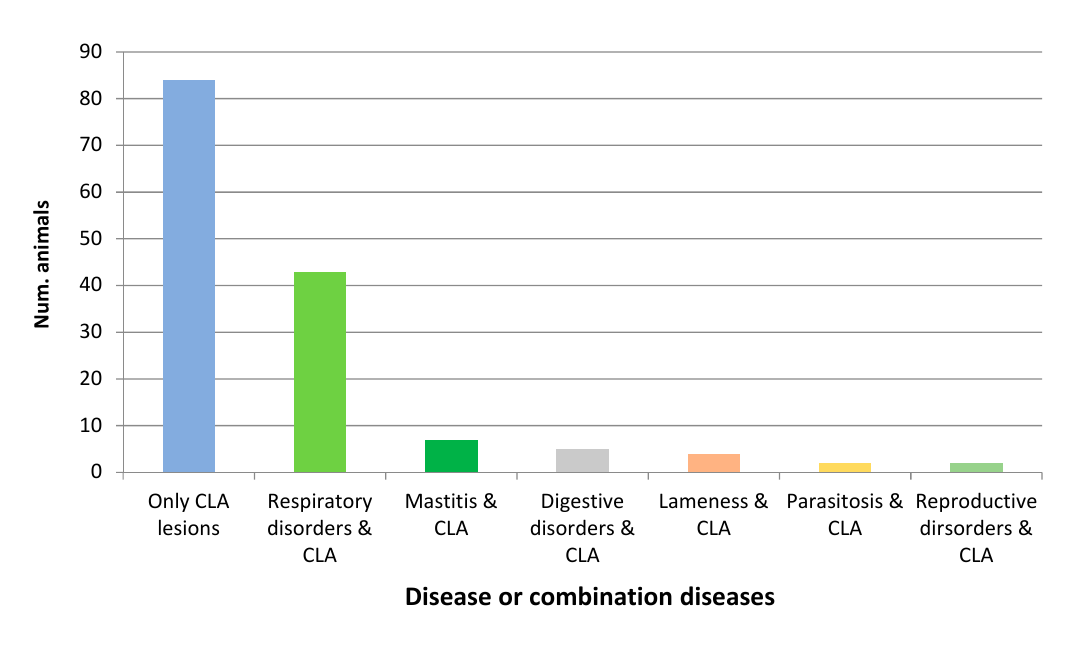
Table 2. Number and percentage of the affected superficial lymph nodes (LN).